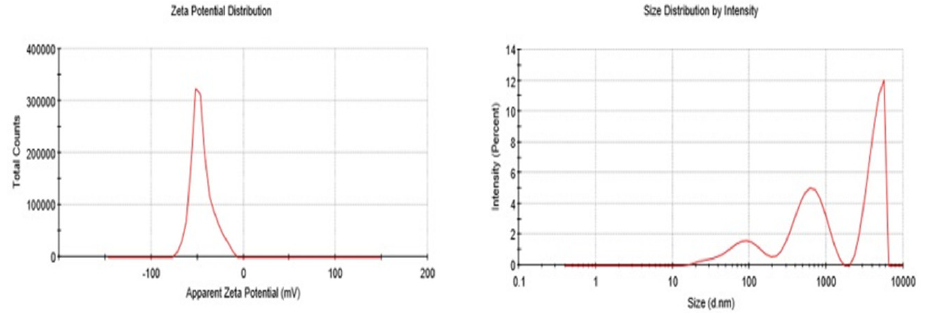
Figure 7. Rheograms of formulation kept at ( A ) (fresh), ( B ) (after 30 days), ( C ) (after 60 days), ( D ) (after 90 days).